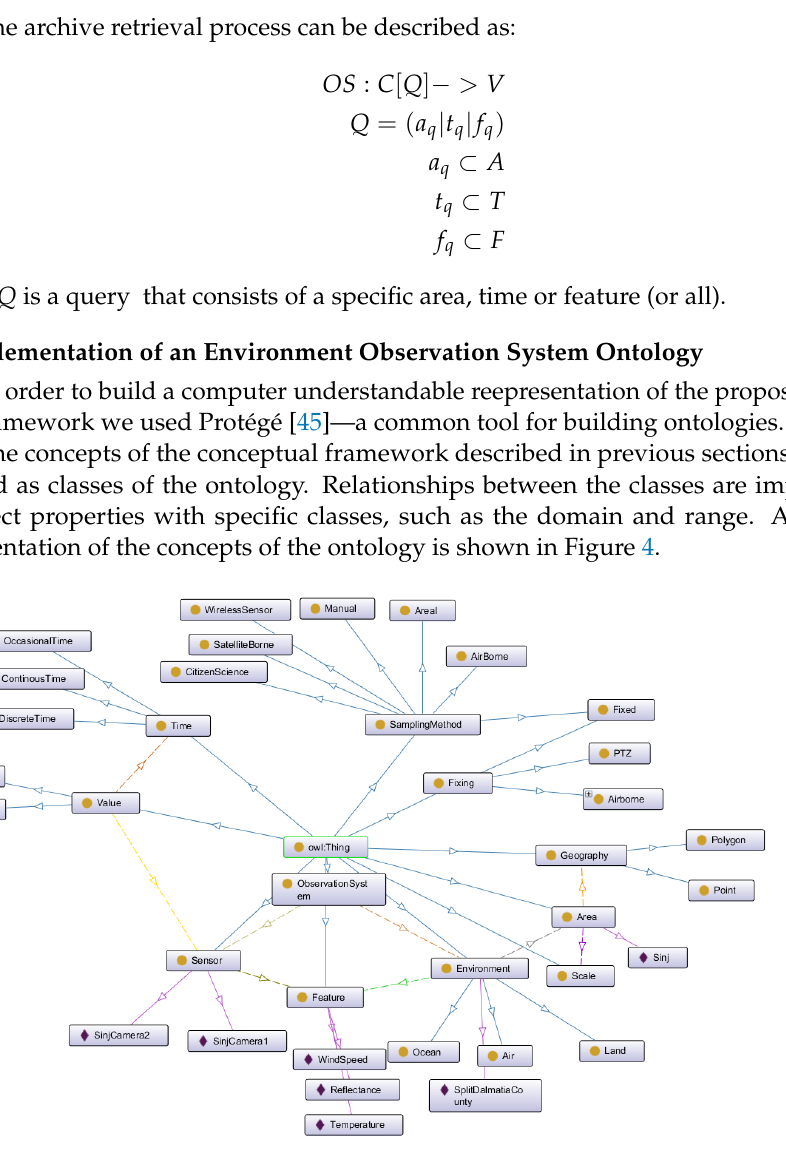
Figure 4. Graphical representation of ontology classes of the environmental observation